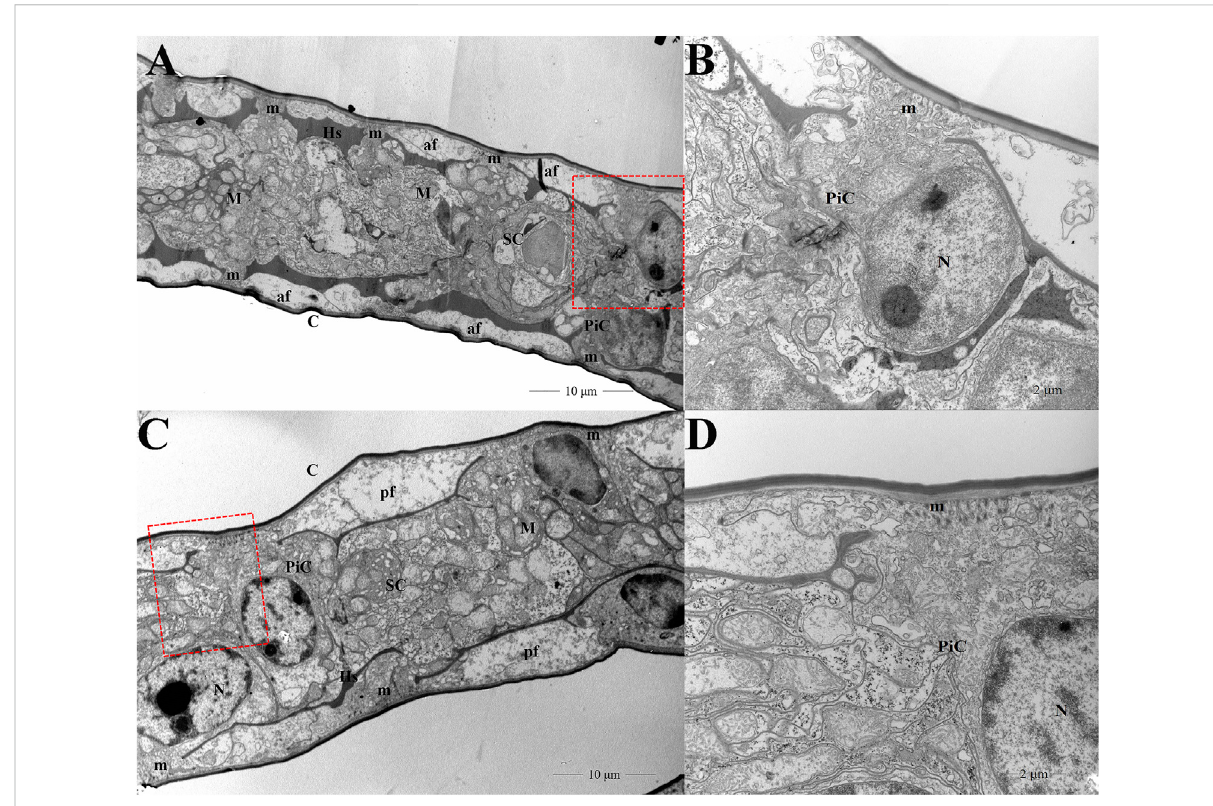
FIGURE 1 Gillultrastructureoftransversesectionsinthecontrol (A,B) andpHgroup (C,D) .Figures1C,DweretheenlargementofredframeinFigures1A,B, respectively. C cuticle; Hs hemolymph space; M mitochondria; N nucleus; m microvillus; PiC pillar cells; SC septal cells; af apical fl